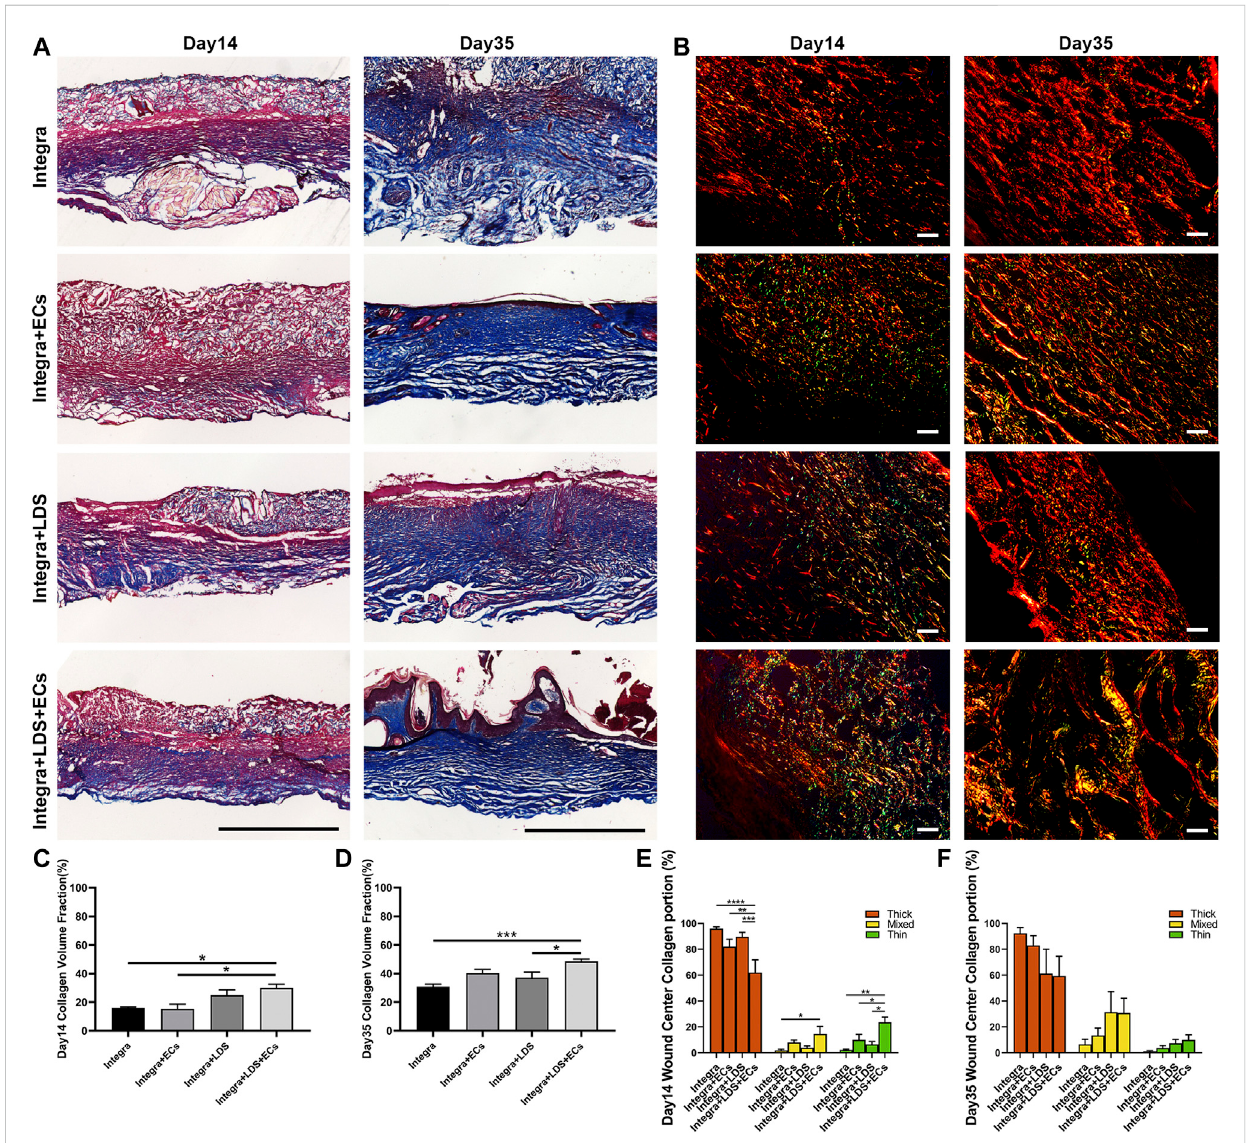
FIGURE 5 Histology evaluation of collagen deposition and portion of wounds treated by different groups at Day 14 and Day 35. (A) Representative images of Masson Trichrome staining at Day 14 and Day 35. Collagen stains blue, nuclei stain dark brown, whereas muscles, cytoplasm, and keratinocyte stain red. Scale bar = 1 cm. (B) Representative images of Picro Sirius Red staining under linear polarized light microscope at Day 14 and Day 35. Red birefringence represents thick fi bers (Type I), while green birefringence represents thin fi bers (Type III). Yellow birefringence represents mixed fi ber. Scale bar = 20 μ m. (C, D) Quanti fi cation of the collagen volume fraction at Day 14 and Day 35. (E, F) Quanti fi cation of the percentage of collagen type of total collagen at Day 14 and Day 35. Data are expressed as mean ± SEM. * p < 0.05, ** p < 0.01, and *** p < 0.001, and **** p <